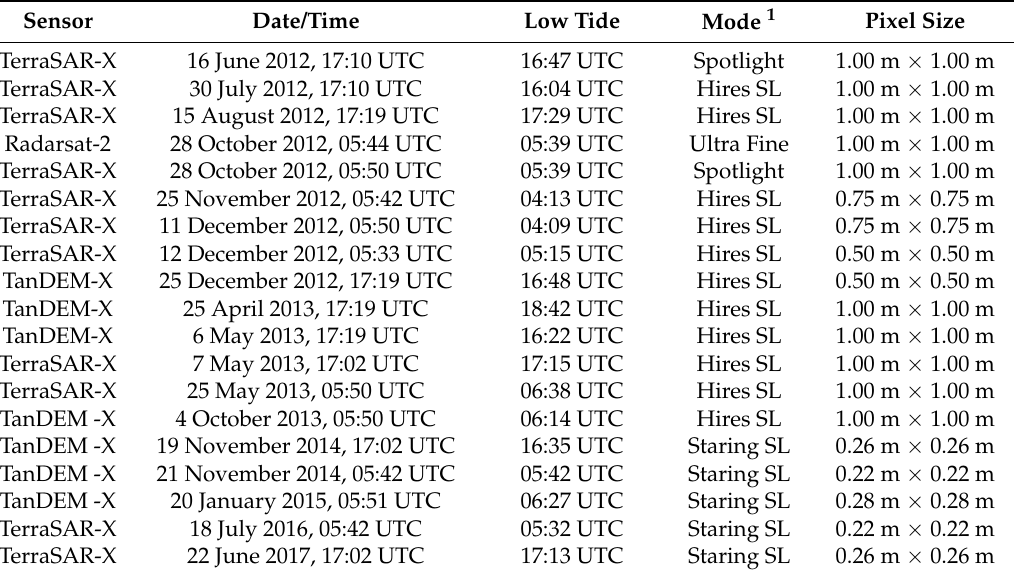
Table 1. SAR data used in the present